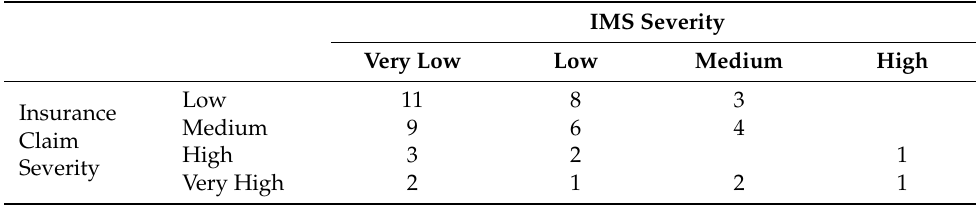
Table 3. Contingency table of injury severity classifications.